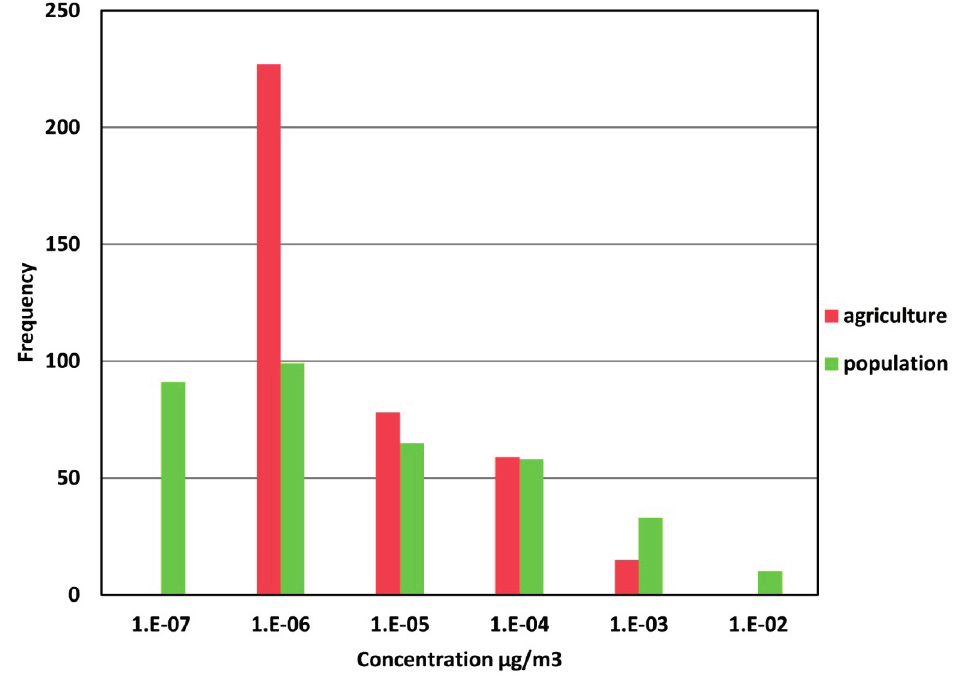
Figure 2. Histogram of γ -HCH concentration (µg/m 3 ) computed with Equation (5) for the year 1995 with the distribution of emissions according to agriculture or to population